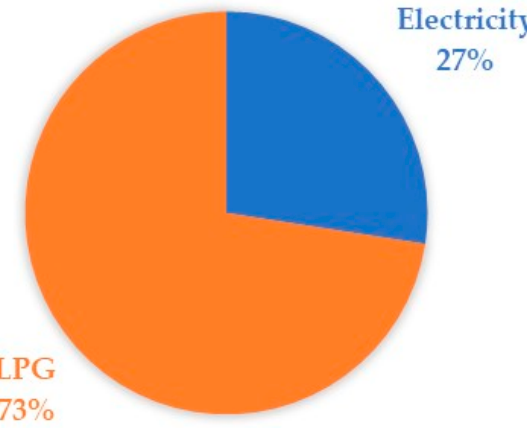
Figure 4. Scenario 0. Energy consumption in 2030, residential sector.